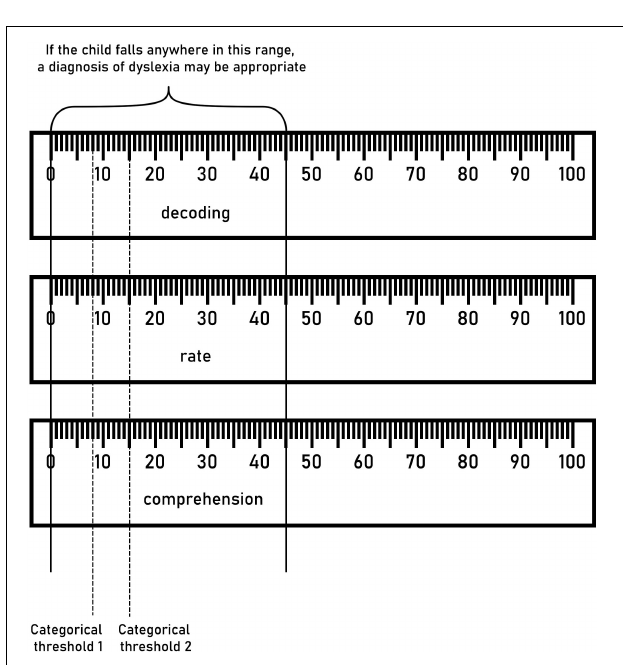
FIGURE 1 | Chart combining categorical and dimensional approach. Some children in the “gray area” from our sample are reported.